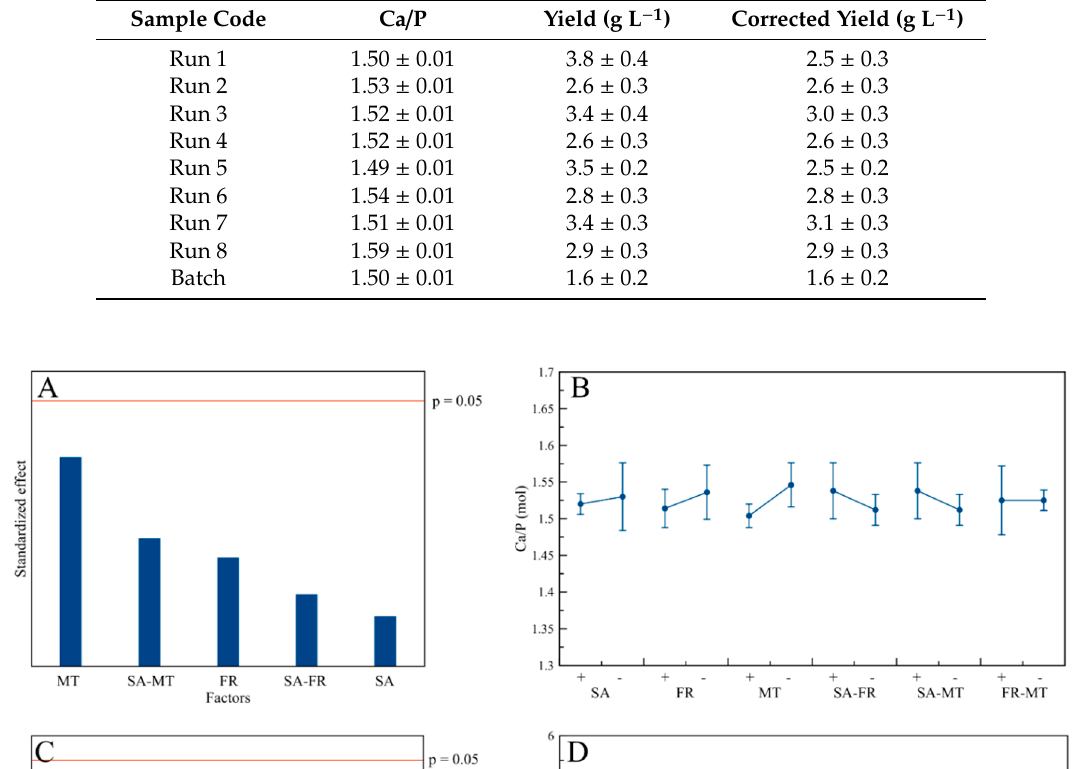
Table 3. Ca / P molar ratio of CaP NPs samples.